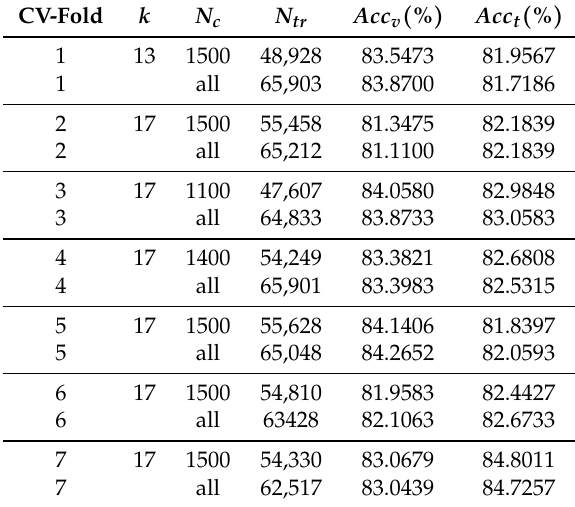
Table 2. Results for sample reduction by Ward’s hierarchical clustering. A seven-fold cross-validation experiment is performed on CB513